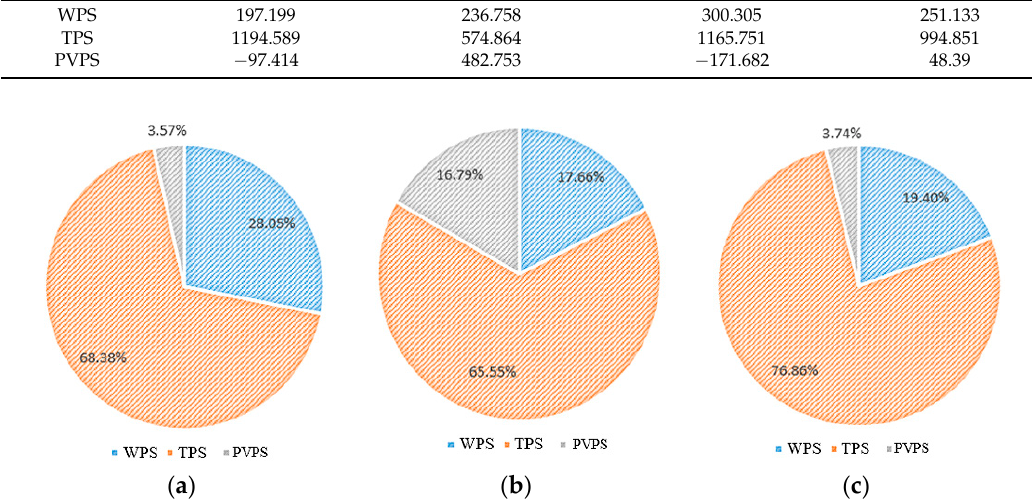
Figure 10. Income Proportion in Different Distribution Strategies. ( a ) Original Income Proportion; ( b ) Income Proportion Based on the Shapley Value; ( c ) Income Proportion Based on Comprehensive Improved Value. WPS: wind power seller; TPS: thermal power seller; PVPS: photovoltaic power